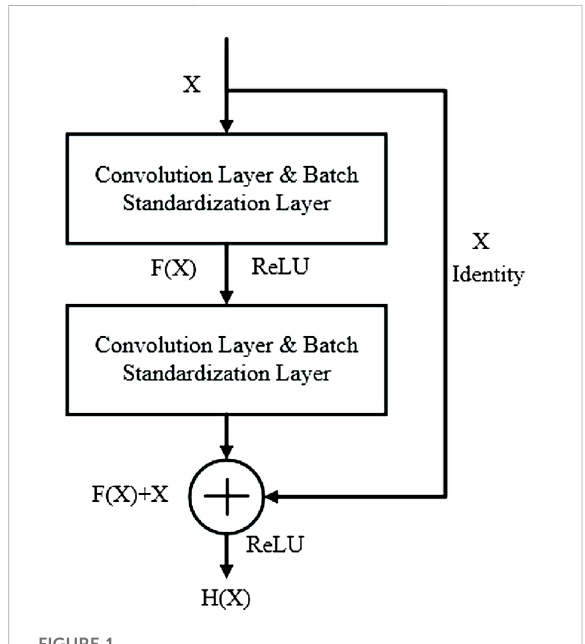
FIGURE 1 Residual block structure